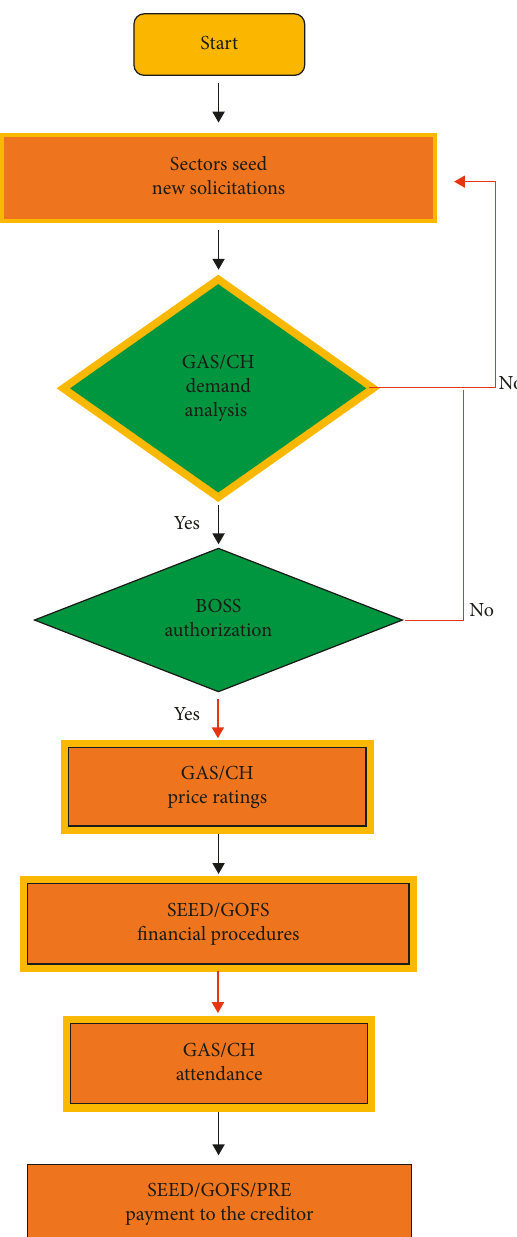
Figure 10: Flowchart drawing of case